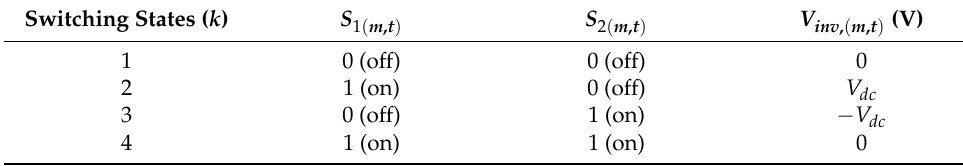
Table 1. The possible switching states of